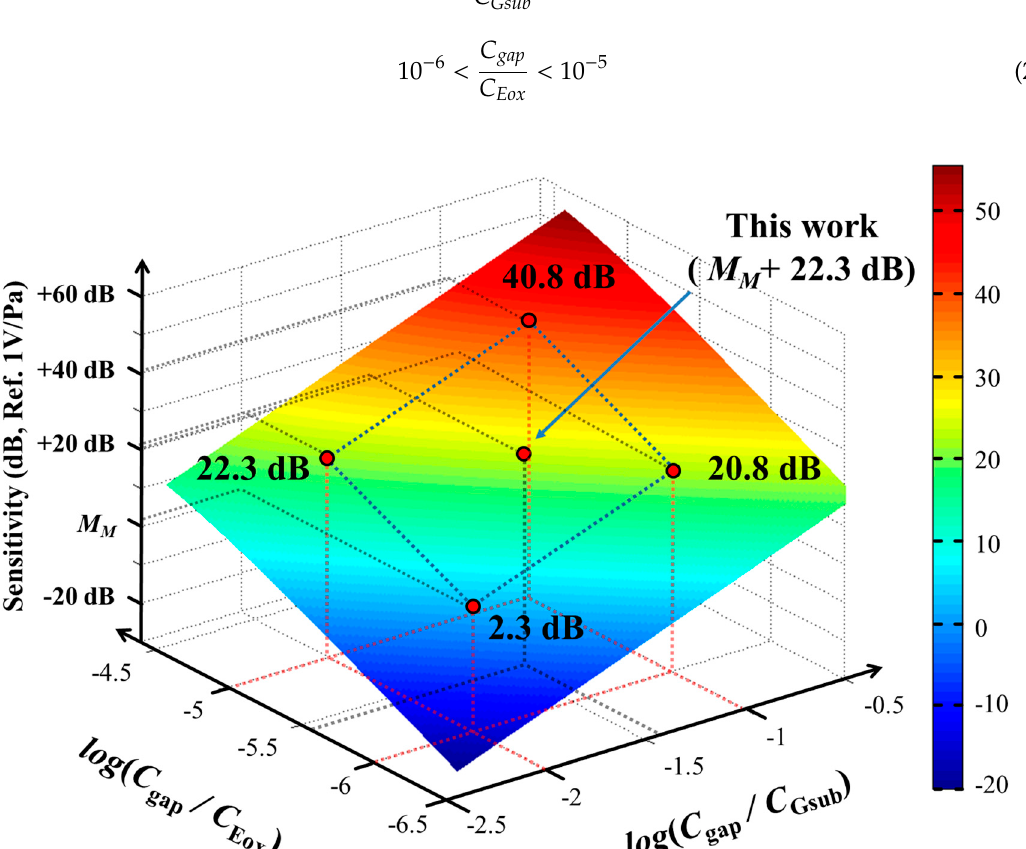
Figure 5. Sensitivity calculation of the ElGoFET microphone based on Equation (21).